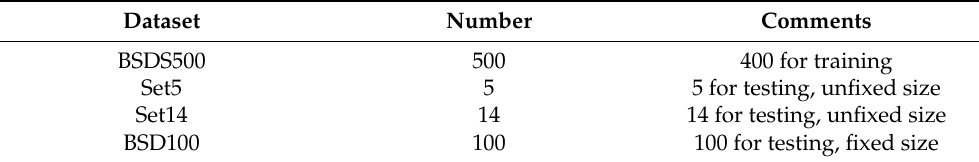
Table 2. Summary of the